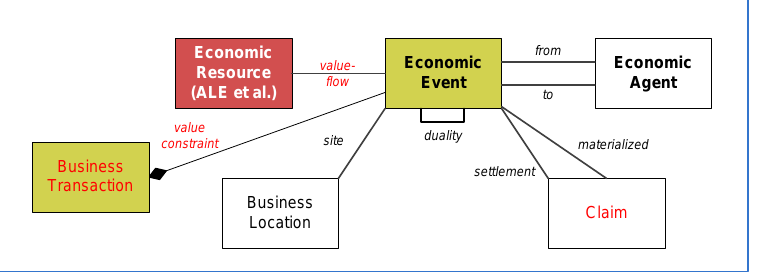
Figure 5. REA-based ALE Accounting model [12] – UML